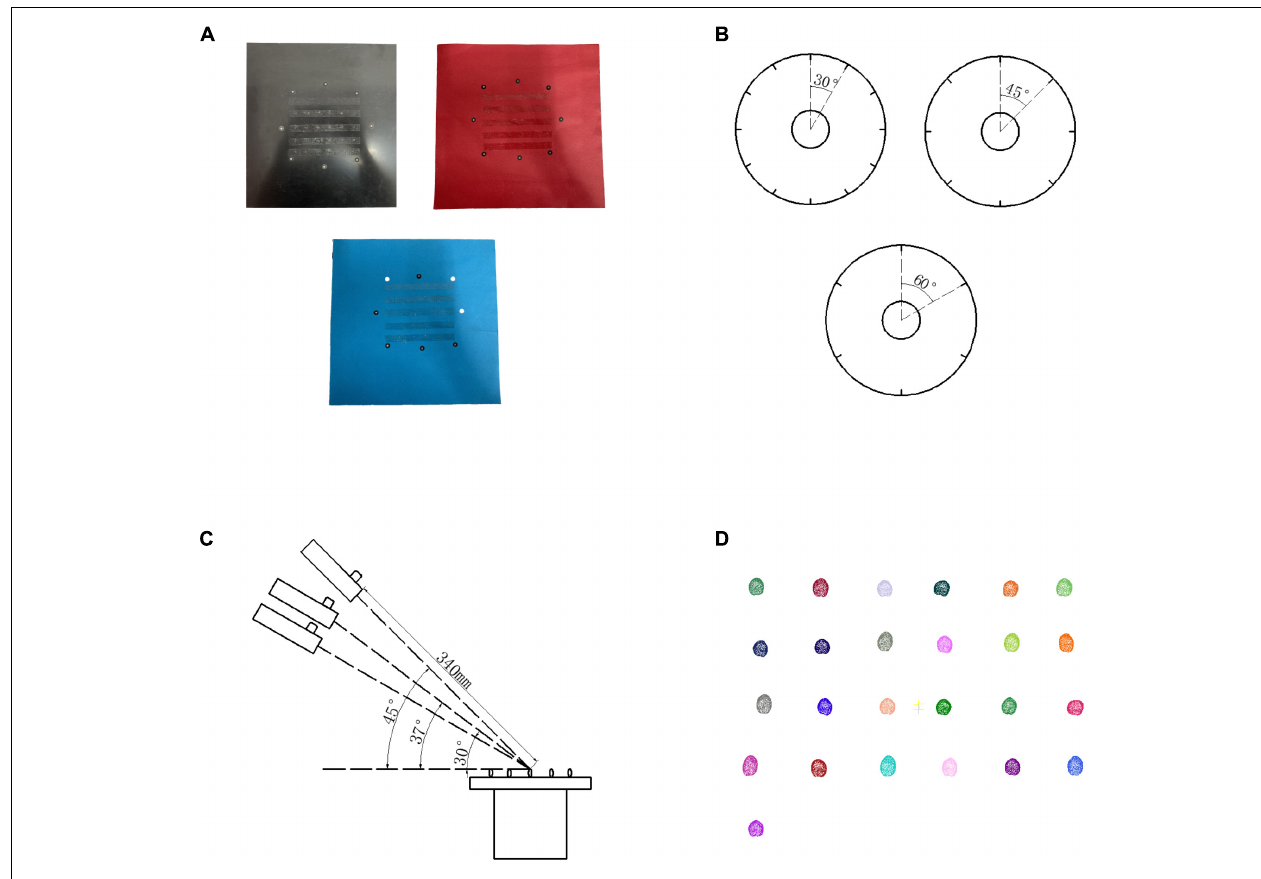
FIGURE 2 | Orthogonal experiment design. (A) Wheat stages in 3 different colors. (B) Rotation method in different angle. (C) Scanning method in three different angles. (D) Wheat grain point clouds by structure light imaging.